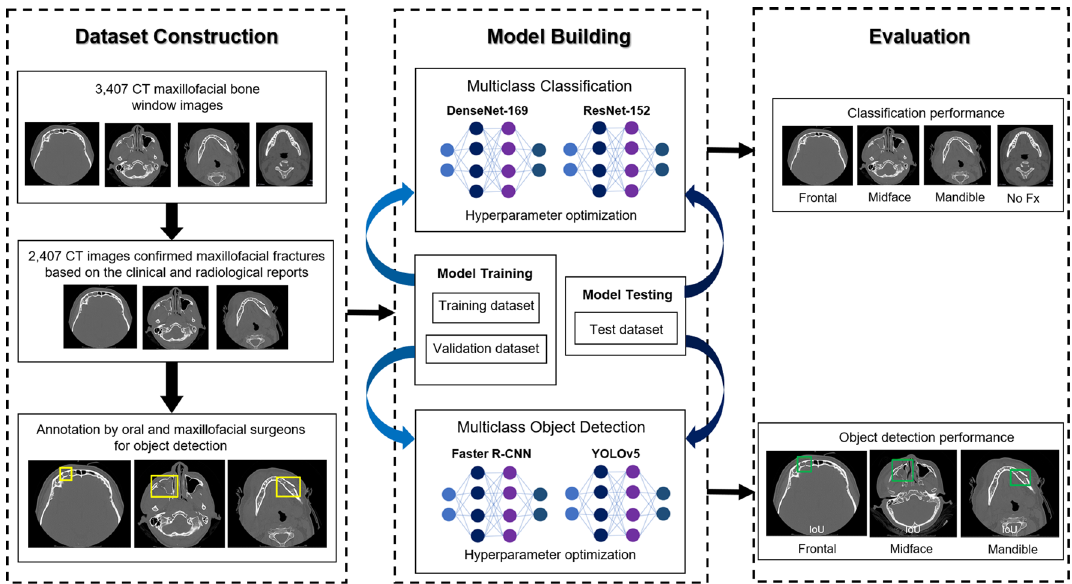
Figure 1. The CNN workflow of data set construction, model building and evaluation. CNN convolutional neural network, CT computed tomography, Fx